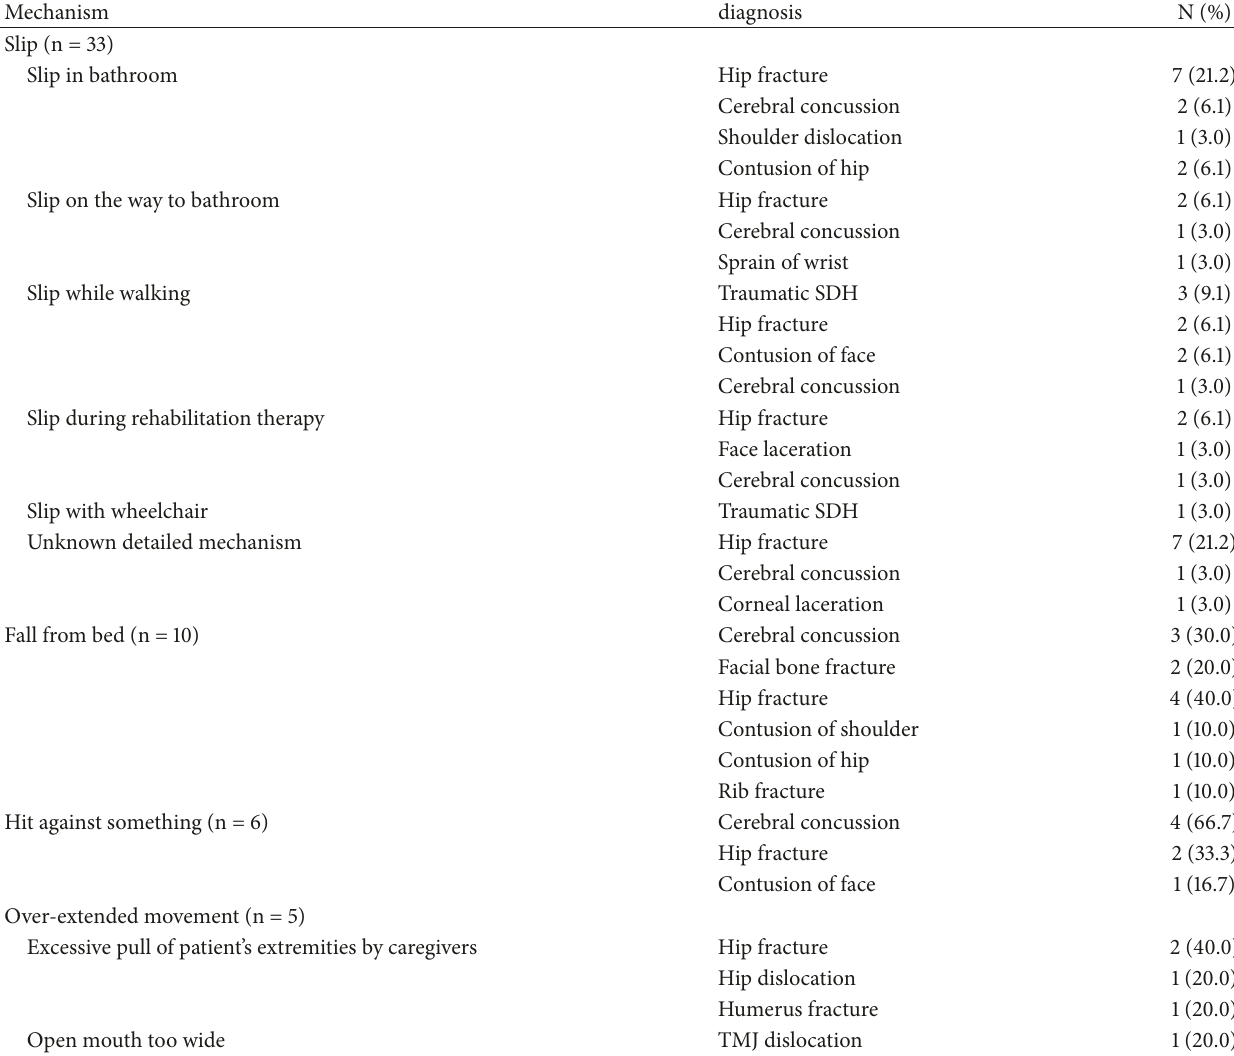
Table 2: Detailed mechanism of trauma from long-term care